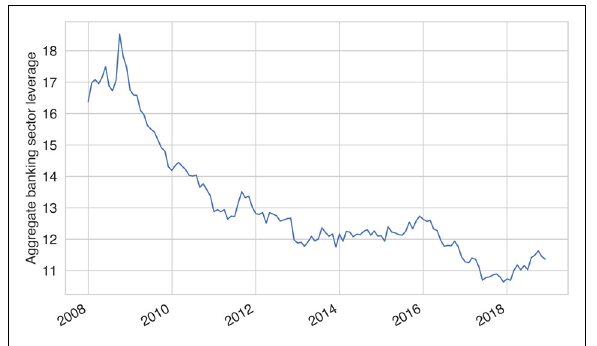
Figure 6: Leverage ratio averaged over for the largest 10 banks from January 2010 to February 2020. Leverage is defined as debt/ equity (book value).